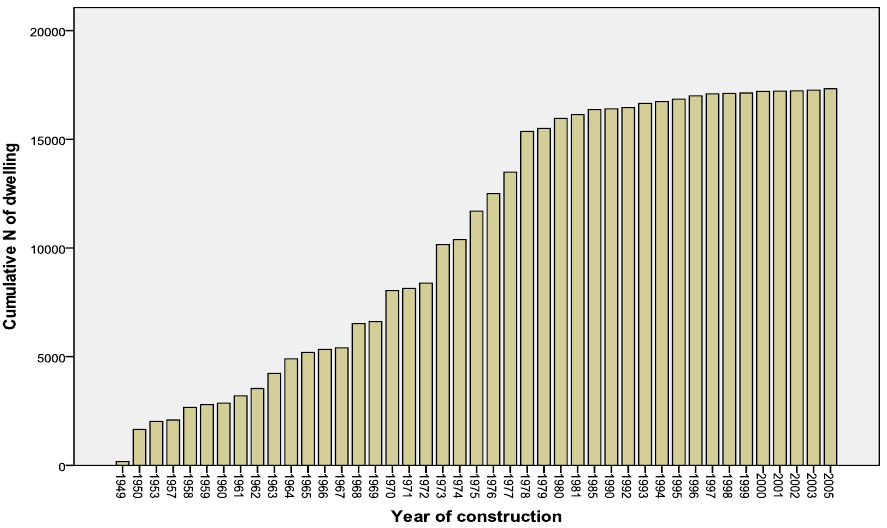
Figure 1. History of construction of the Lille Metropole Habitat (LMH) social housing stock (cumulative).